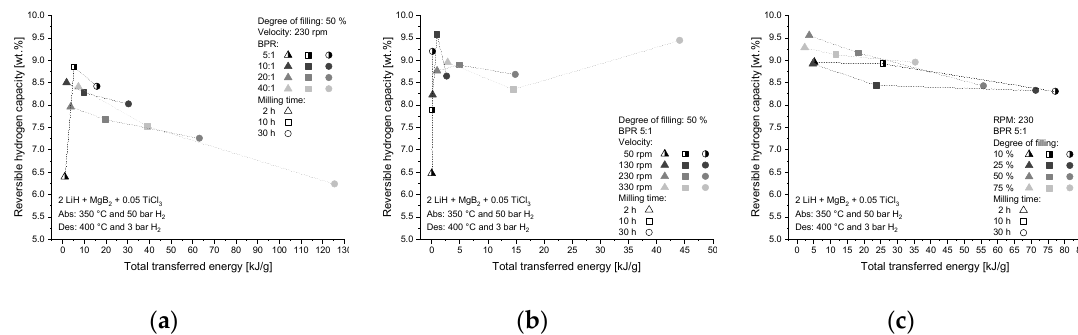
Figure 6. Reversible hydrogen capacity as a function of total transferred energy for different milling times as well as ( a ) BPRs, ( b ) milling velocities, and ( c ) degree of filling.